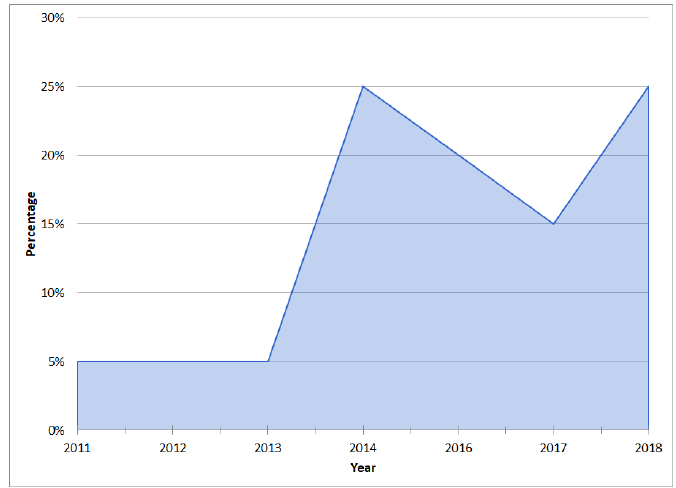
Figure 9. Wireless IoT protocol usage per